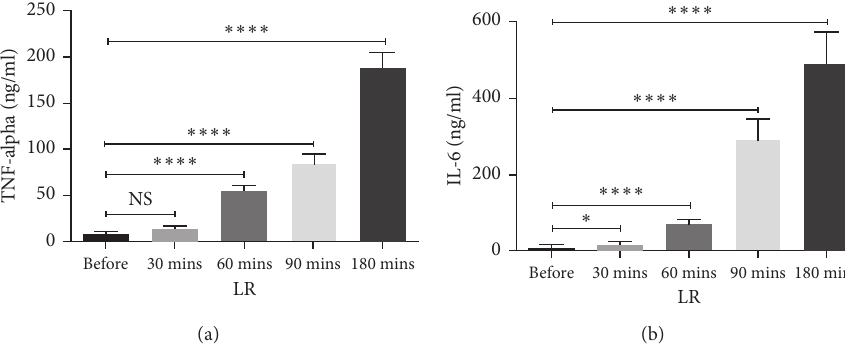
Figure 2: The effect of liver regeneration on the serum concentrations of proinflammatory cytokines in HCC patients. The levels of TNF- α and IL-6 in patients with HCC were measured before and after liver regeneration using ELISA ((a) and (b)). The depicted results are representative of 15 independent experiments for HCC subjects. All data are shown as mean ± SEM. ∗ P < 0 . 05 and ∗∗∗ P < 0 .